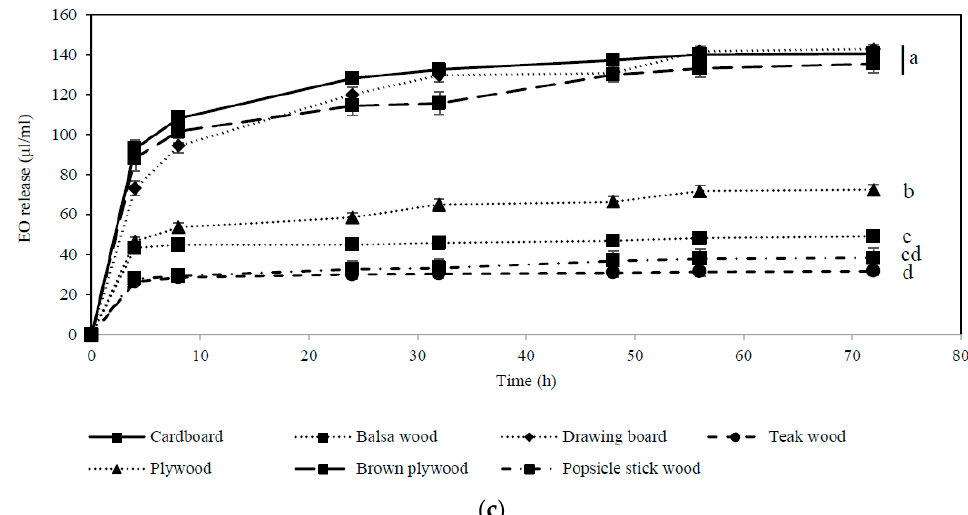
Figure 2. Absorption capacity ( a ), holding capacity ( b ), and release rate ( c ) of A. krervanh EO by different materials. Data shown are the means ± standard deviation. Different lowercase letters represent significant difference ( p < 0.05). Comparisons of holding capacity and release rate of essential oil were made between materials at each time interval.